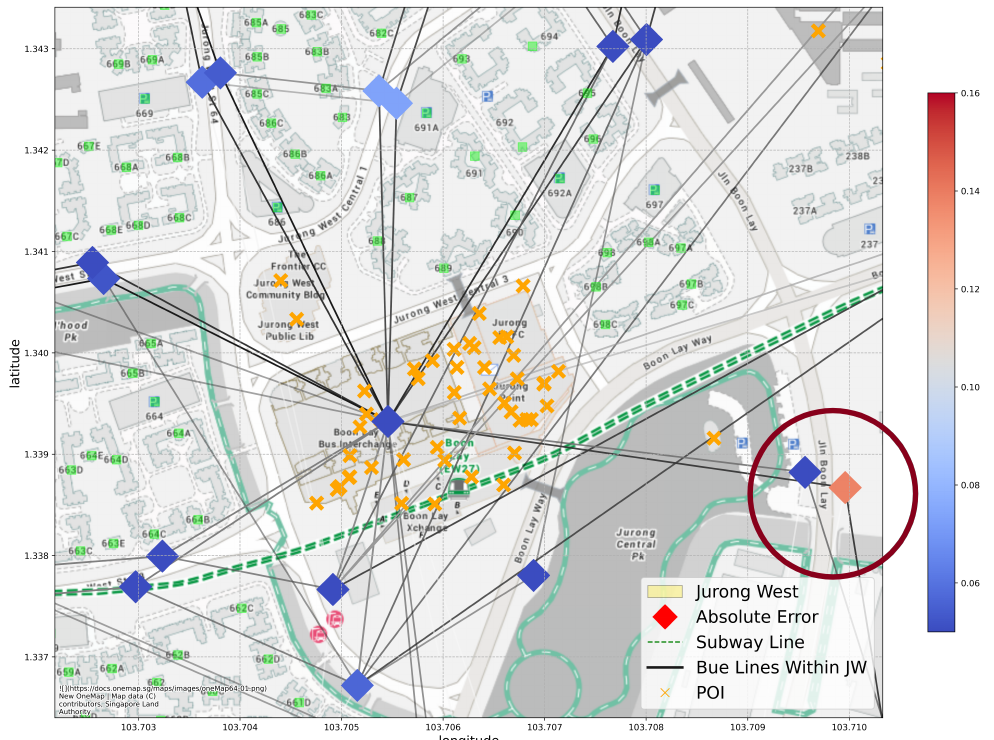
Figure 9. An example of an unsuccessful prediction in our GCN model.The two nodes in the circled area are centered around Stop 21351 ( left ) and Stop 21359 ( right ). They appear to share similar local geographic features and transport connections, but the circumstances are quite